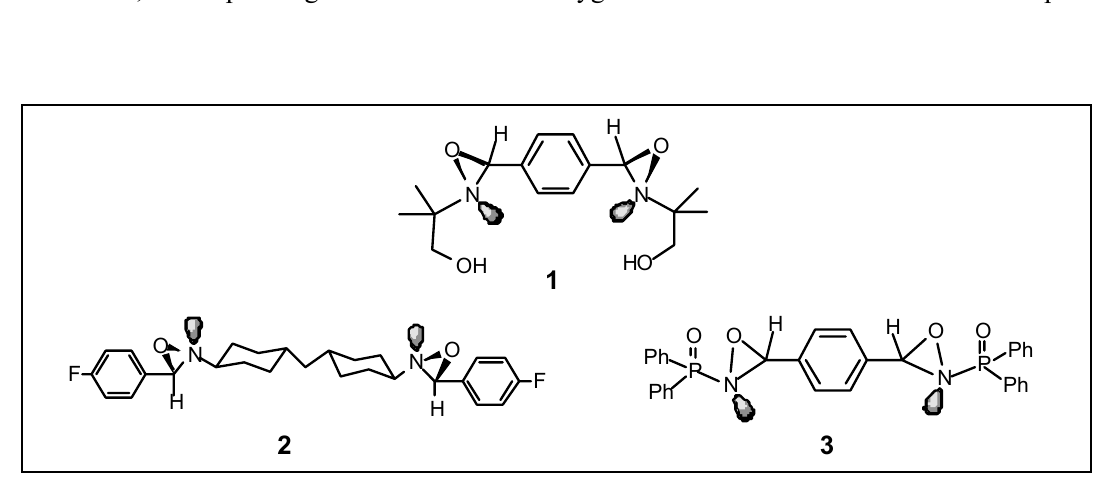
Figure 3. Structures of the bisoxaziridines 1 , 2 , and 3